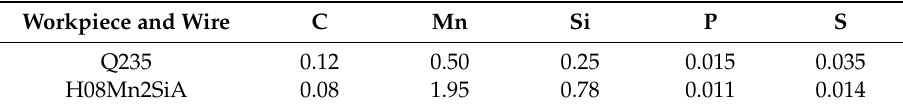
Table 2. Components for Q235 and H08Mn2SiA.